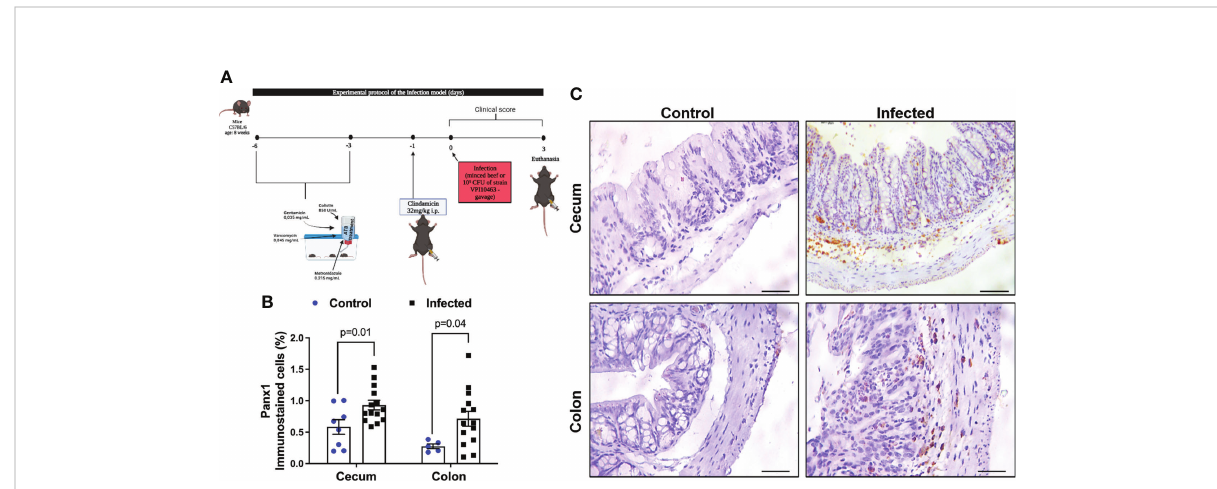
FIGURE 1 CDI increases Panx1 expression in mouse colon and cecum samples. (A) Experimental protocol of the infection model. (B) CDI increases Panx1 immunostaining in the cecum and colon of mice. The data are the mean ± SEM of the percentage of the immunopositive area for Panx1 in the cecum and colon of mice submitted to CDI and uninfected in relation to the total area; t test of Student; the value of p is represented in the graph. (C) immunohistochemical imaging for Panx1 in mouse colon and cecum tissues with CDI (Bars=100 m